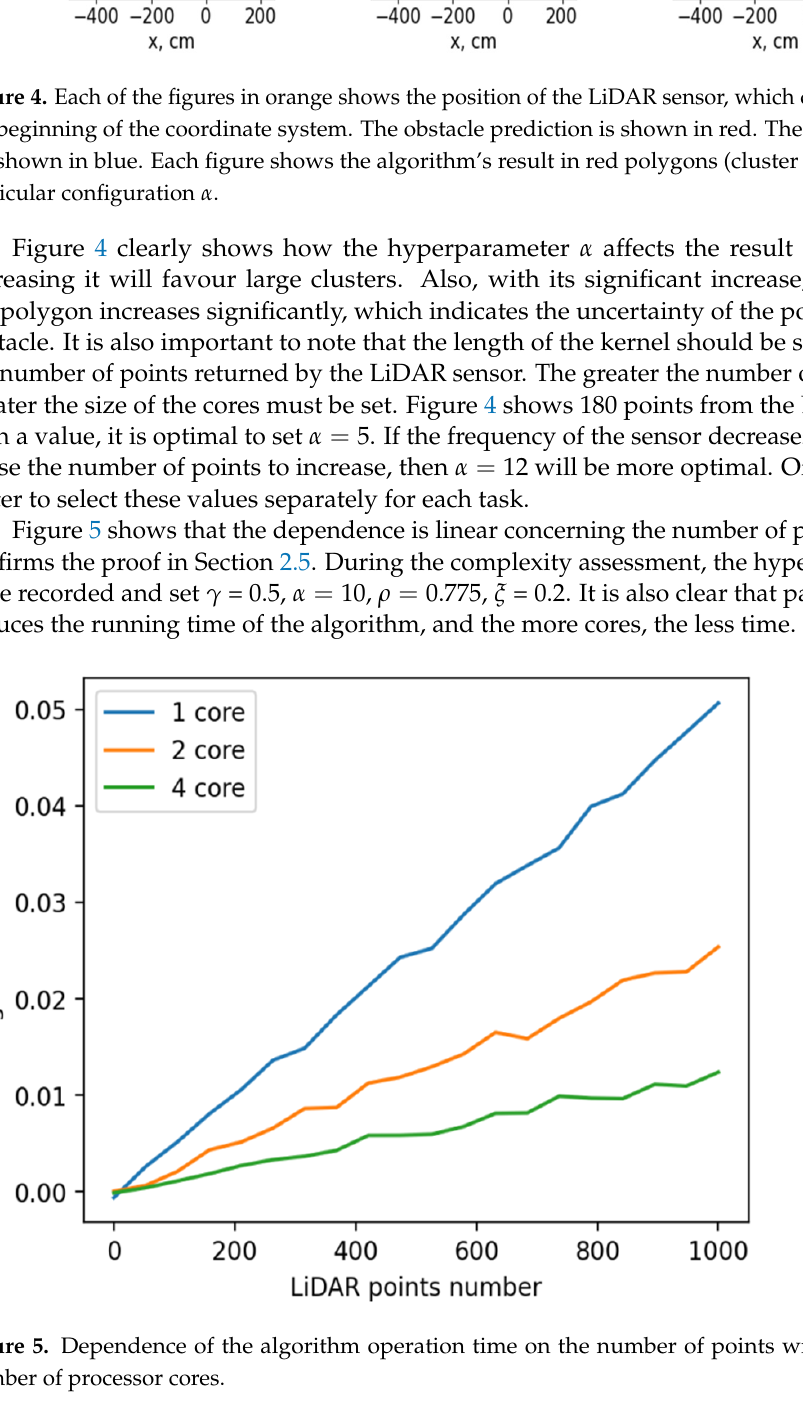
Figure 5. Dependence of the algorithm operation time on the number of points with a different number of processor cores.